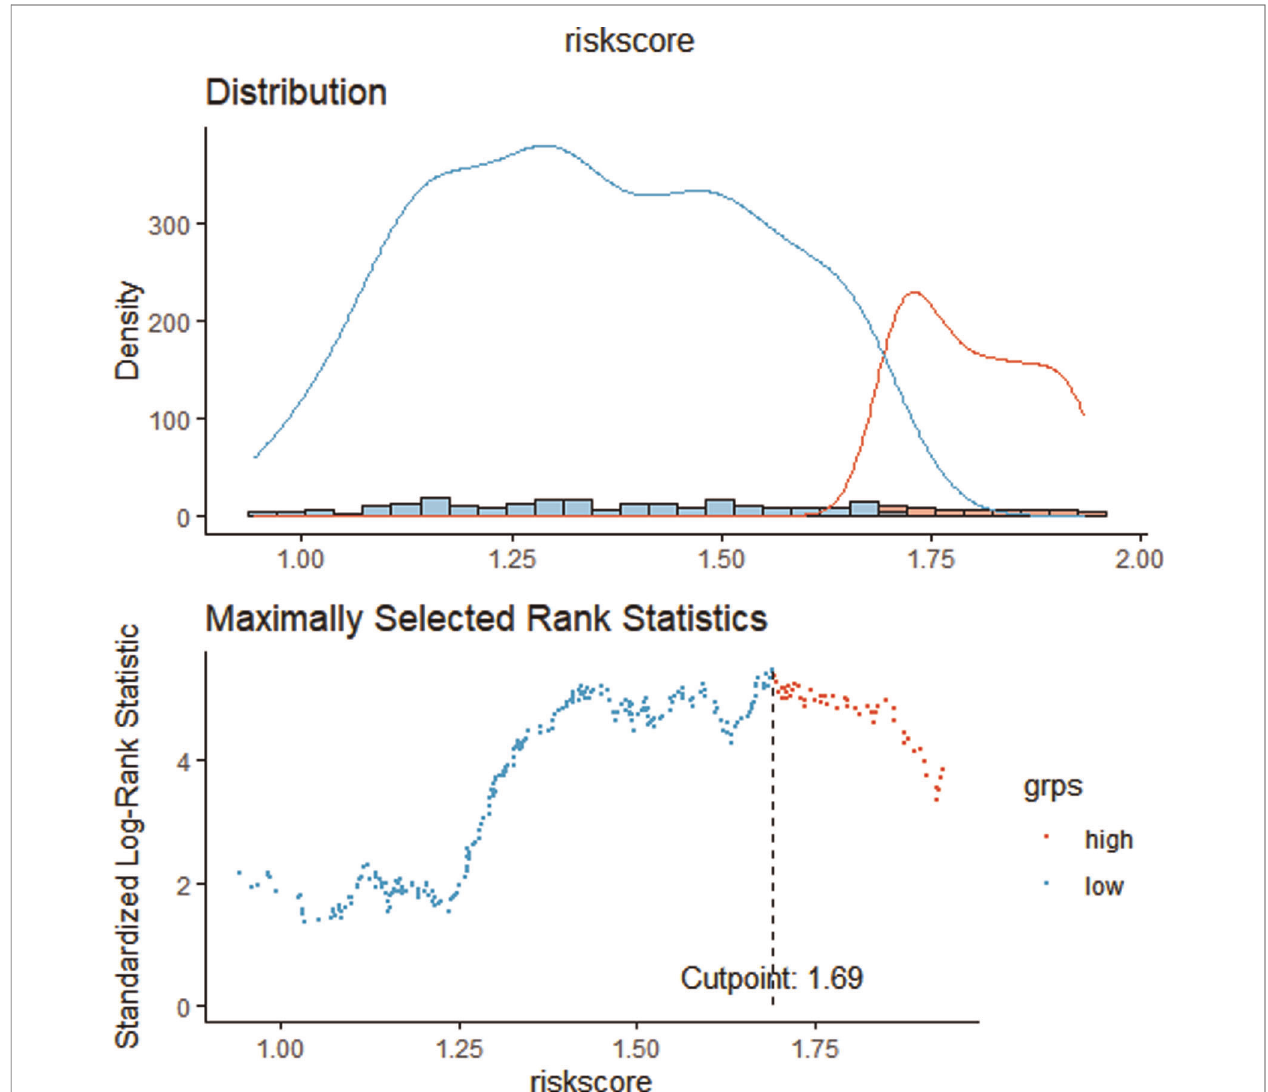
FIGURE 7 | Determination of